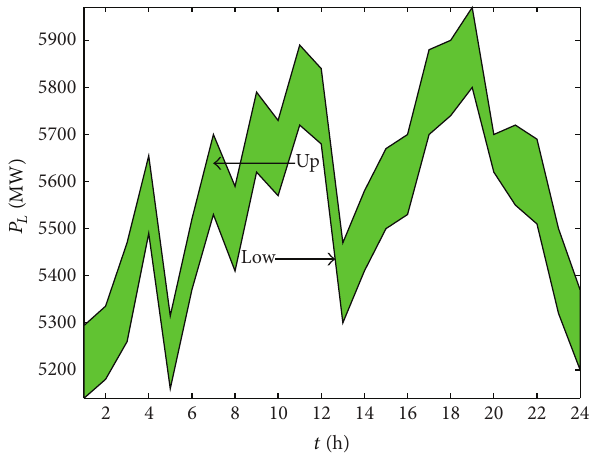
Figure 3: Prediction of the load interval value.